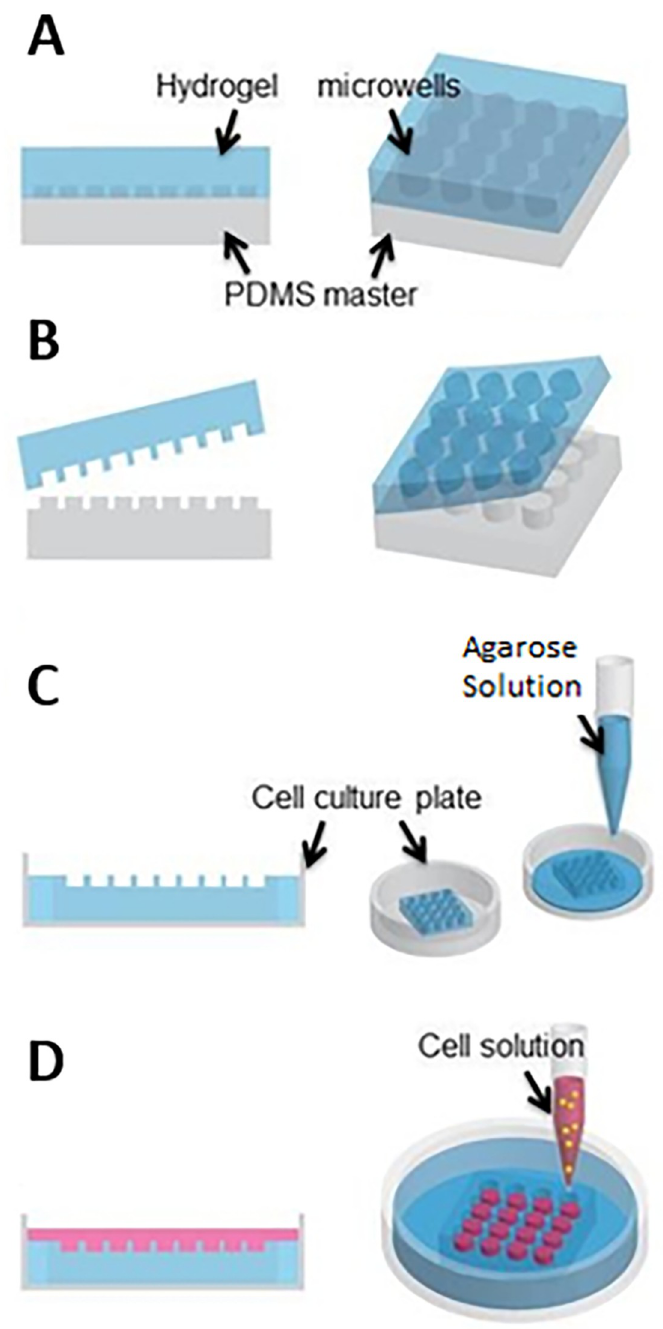
Fig 1. Schematic of agarose microwell fabrication and cell seeding for preparation of glioma spheroids.